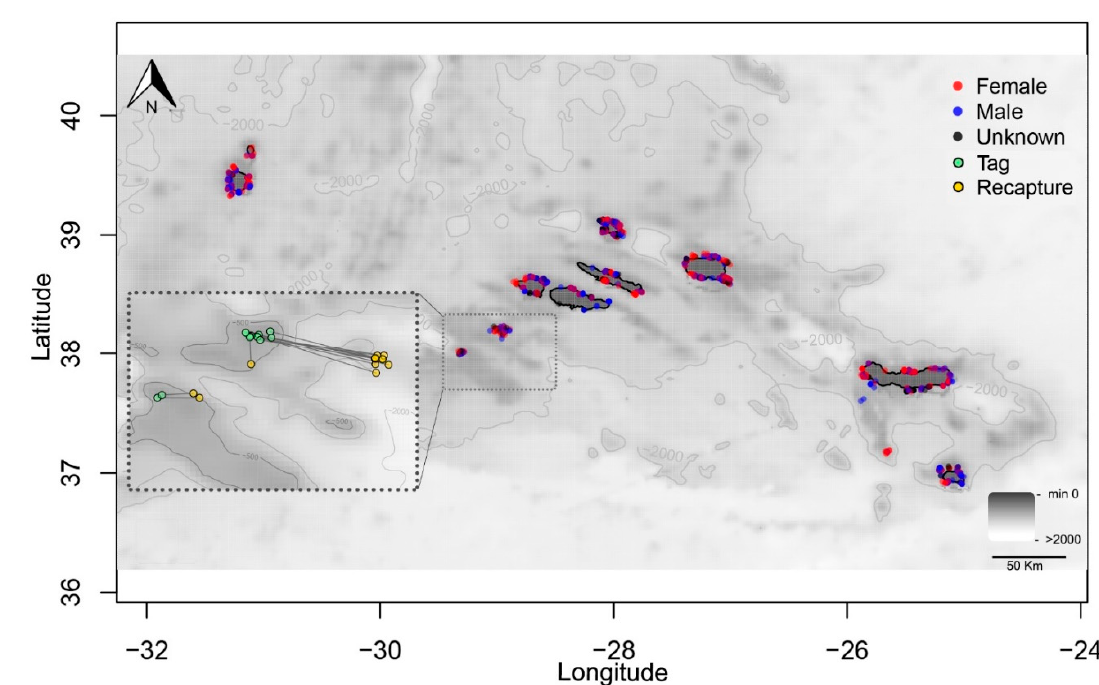
Figure 2. Tag release locations of female (red points), male (blue), and unsexed (black) thornback ray Raja clavata during scientific surveys (1996 – 2019) in the Azores. The green and yellow points indicate the release and recapture locations, respectively, of the 13 recaptured fish. Displacements between release and recapture points are represented by straight lines.